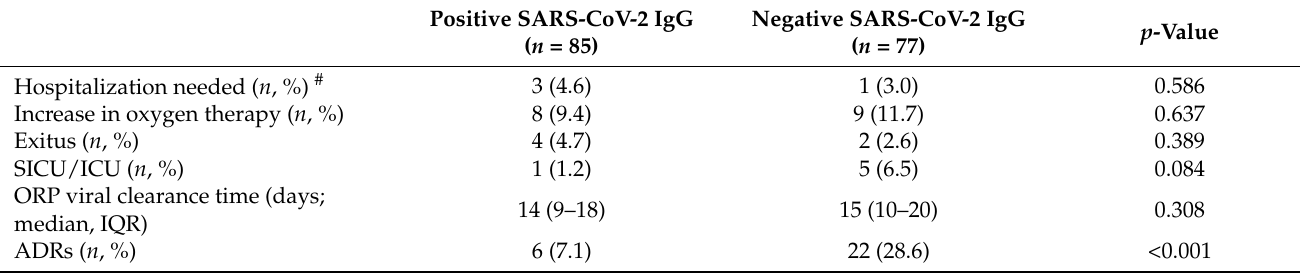
Table 3. Stratified outcomes analysis according to baseline SARS-CoV-2 serology (and =